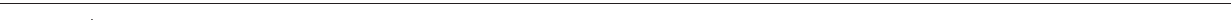
FIGURE 2 | Other family members may have different sequences at the N-terminal or in between the MD and GED domains. Human dynamin superfamily members are grouped according to their domain structure into; classical dynamins (dynamin 1-3), Dynamin related proteins (examples shown; MxA/MxB, Mitofusin 1 and 2, and OPA1), and guanylate-binding proteins GBPs (examples shown; Atlastin 1-3 and GBP 1-5). Structural components are colour coordinated; red: bundle signalling element (BSE), green: G-domain, light blue: middle domain, yellow: PH domain, dark blue: GED, purple: transmembrane domain (T), grey: PRD (Praefcke and McMahon, 2004; Ford et al., 2011), pink: mitochondria localisation signal (MLS) and orange: coiled coil motif (CC). (B) Domain Structure of human dynamin 1 (Ford et al., 2011). Classical domain names are indicated below. (C) Ribbon representation of human dynamin 1. Domains represented by colours coordinating to the domain structure in A. GTPase domain (green), BSE (red), stalk region consisting of the middle domain (light blue) and GED (dark blue) and the PH domain (yellow). Hinge 1 and 2 are labelled (Ford et al.,